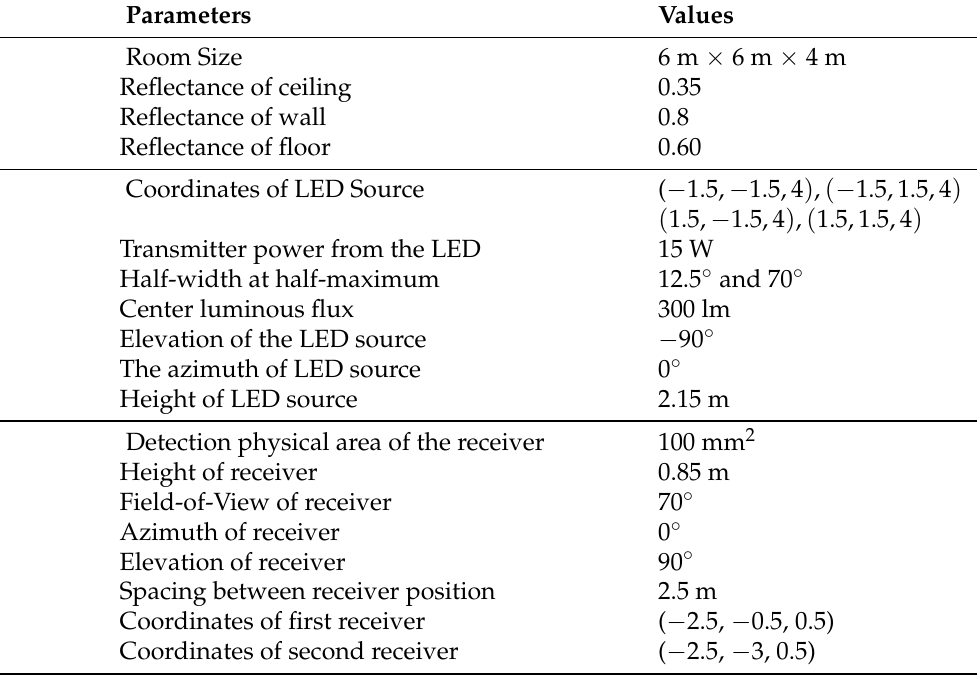
Table 2. Simulation